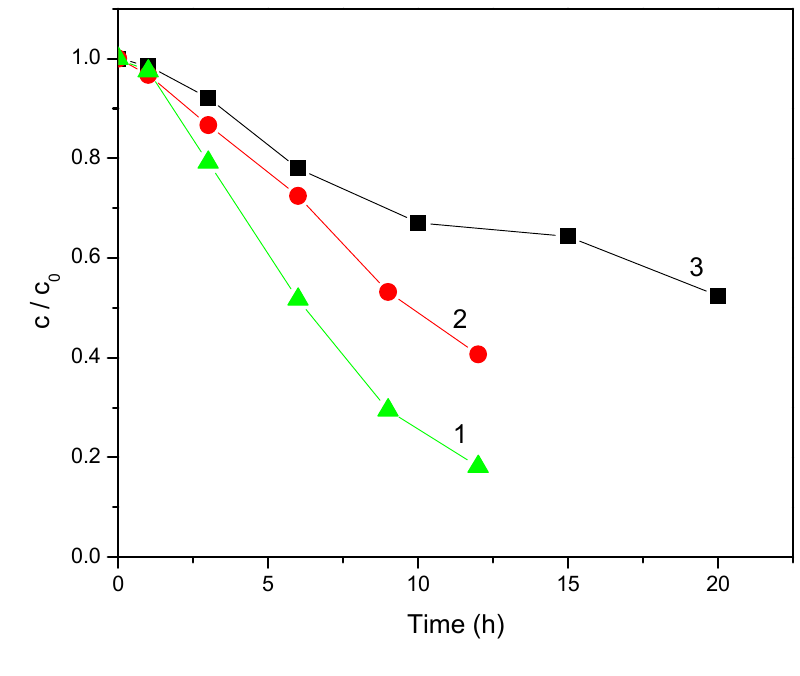
Figure 9. Photocatalytic degradation of mecoprop (2.7 mmol/dm 3 ) in the presence of N- (1 mg/cm 3 ): (1) disappearance of mecoprop (HPLC, λ = 228 nm); (2) doped TiO 2 disappearance of aromatic ring (spectrophotometry, λ = 228 nm) and (3) total organic carbon